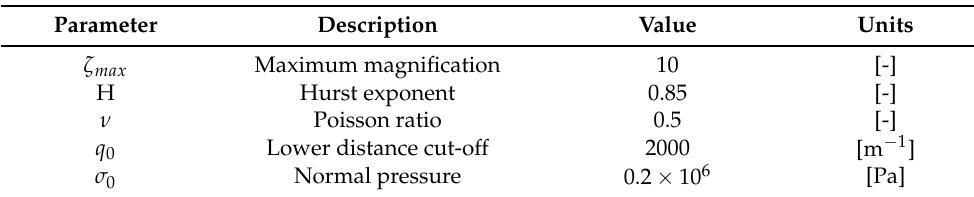
Table 6. Commonly used parameters for Persson’s isothermal friction model [11], employed in the present study.